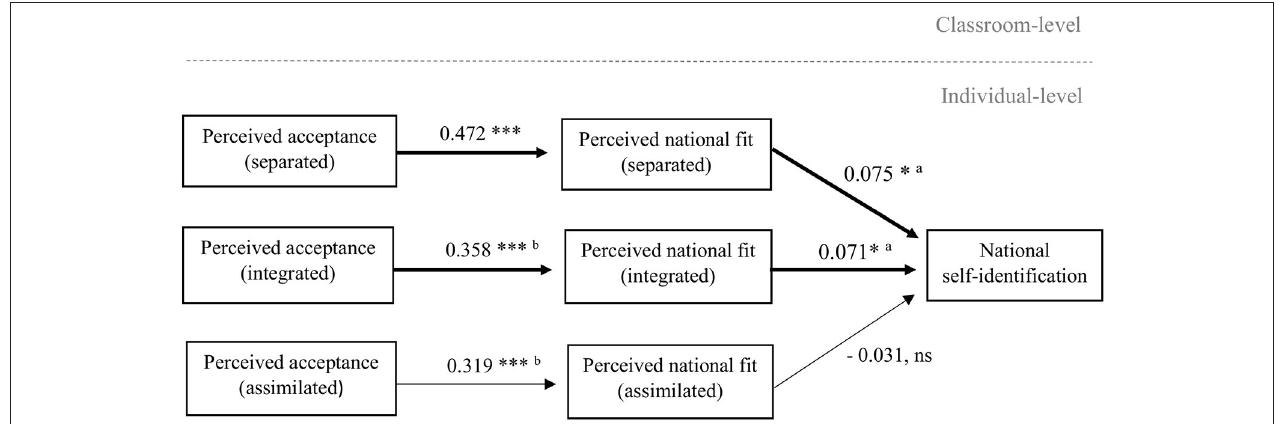
FIGURE 1 | Multi-level path model with national self-identification as the final dependent variable while controlling for student nested in school classes. Standardized regression coefficients are reported, and significant indirect paths are shown with arrows in bold. Identical superscripts indicate effects that did not significantly differ. Full model results, including effects of control variables, are reported in Table 2 . *** p < 0.001, * p < 0.05, ns = not significant at p =